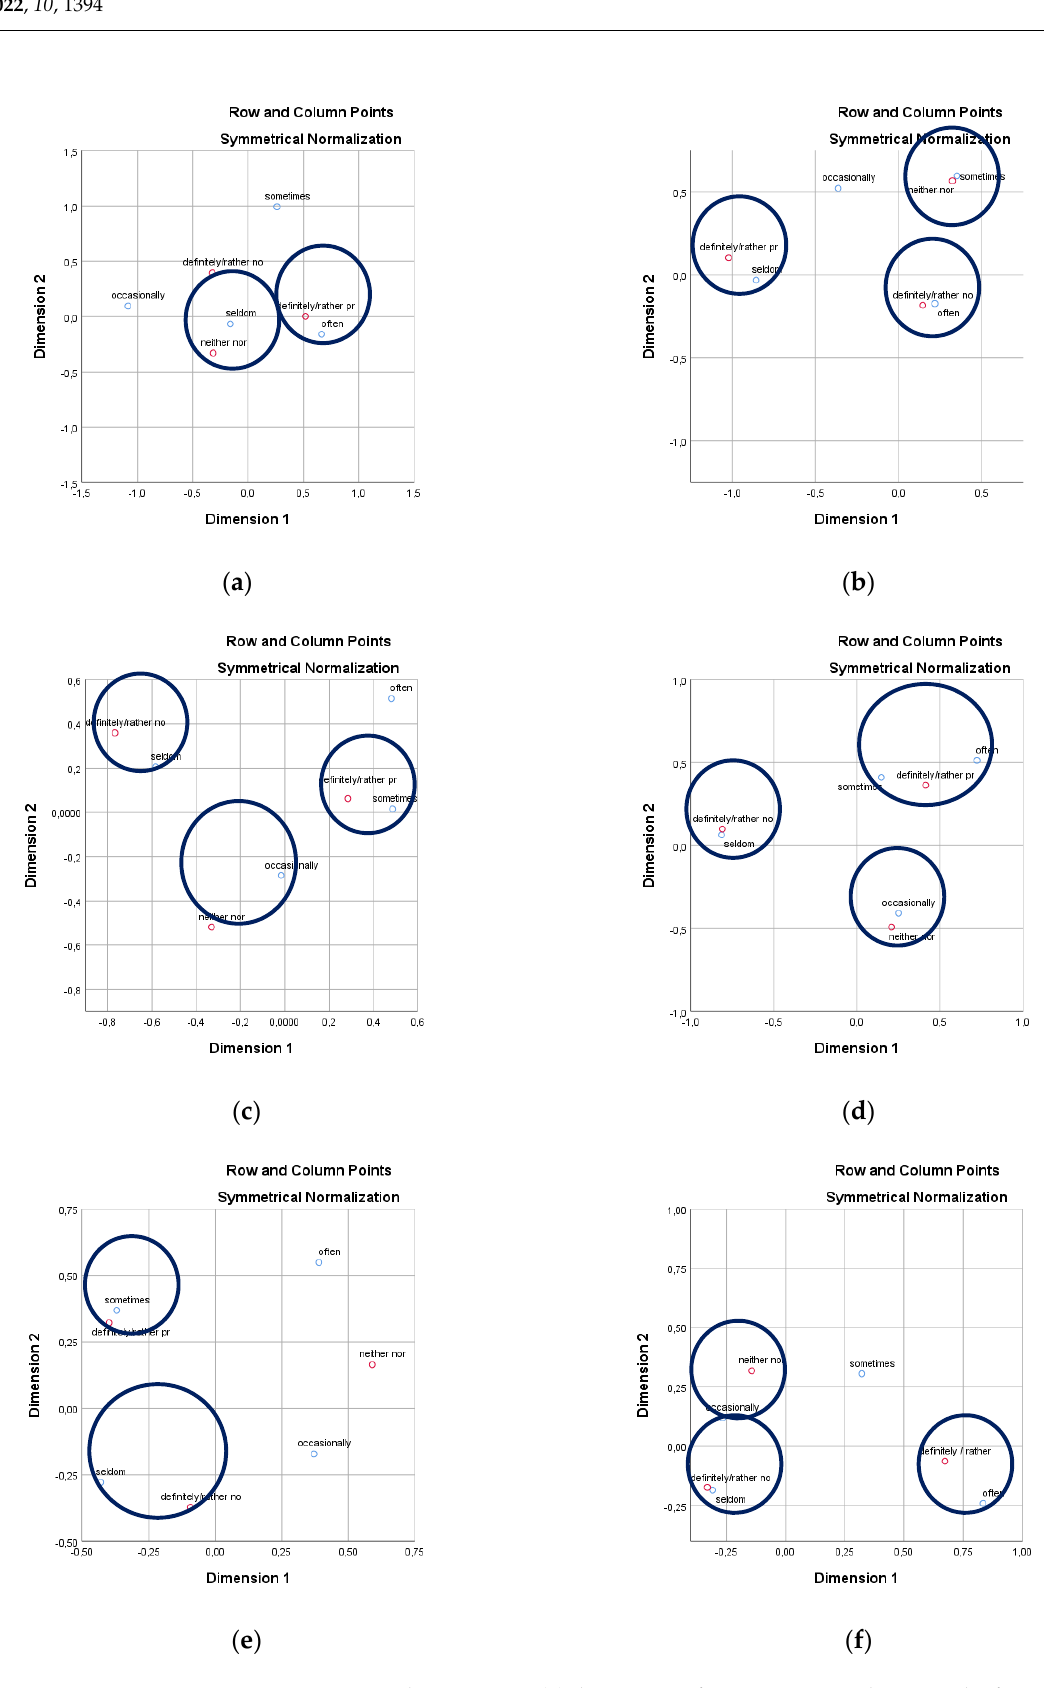
Figure 4. Correspondence maps I: ( a ) there is significant association between the frequency of school visits and the consumer’s preference for shopping in the supermarket before the COVID-19 pandemic; ( b ) there is significant association between the frequency of work visits and the consumer’s preference for shopping through the delivery service before the COVID-19 pandemic; ( c ) there is significant association between the frequency of shopping and the consumer’s preference for shop- ping in the hypermarket before the COVID-19 pandemic; ( d ) there is significant association between the frequency of shopping and the consumer’s preference for shopping in the supermarket before